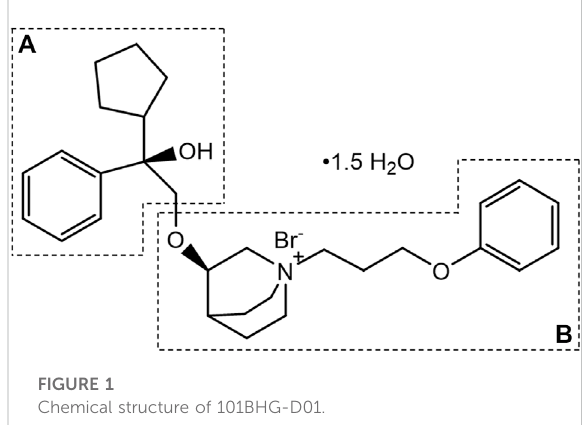
FIGURE 1 Chemical structure of